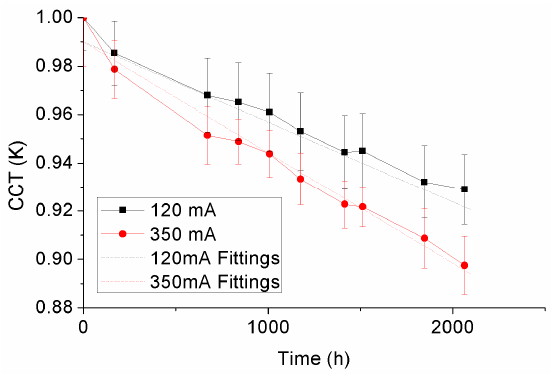
Figure 17. CCT depreciation of the 5000 °K samples. Table 5. Parameters of the linear CCT model.